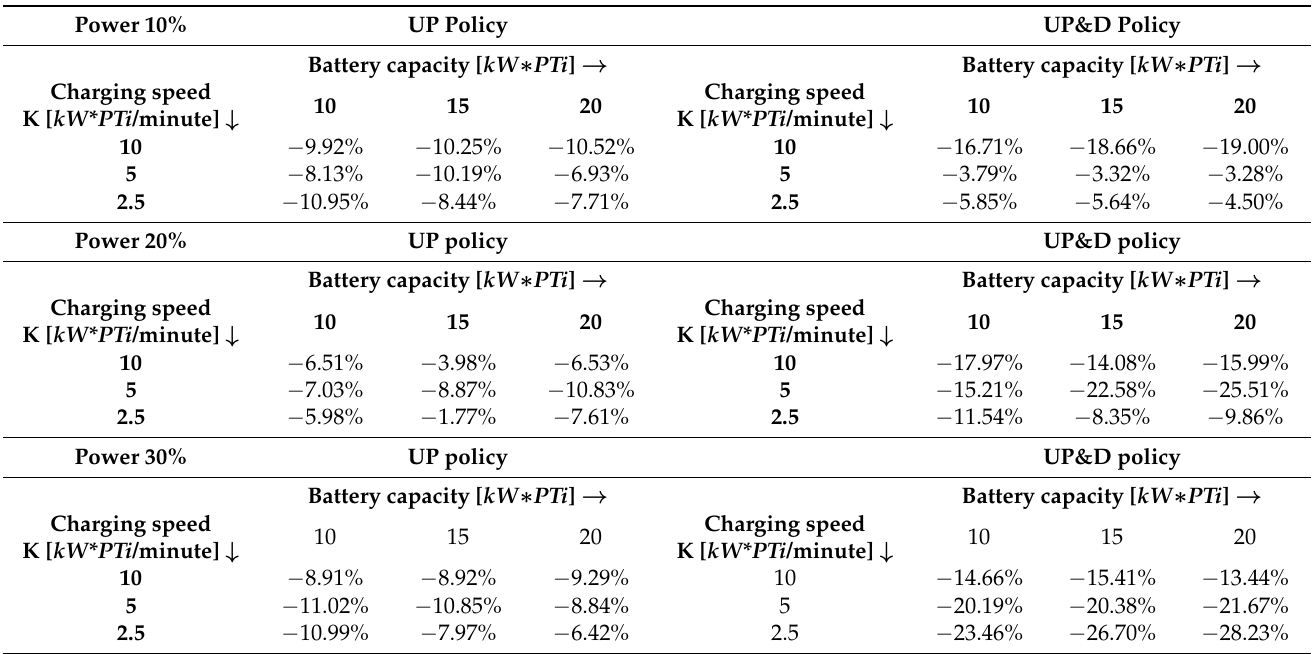
Table 3. Energy used over the peak power switch-off